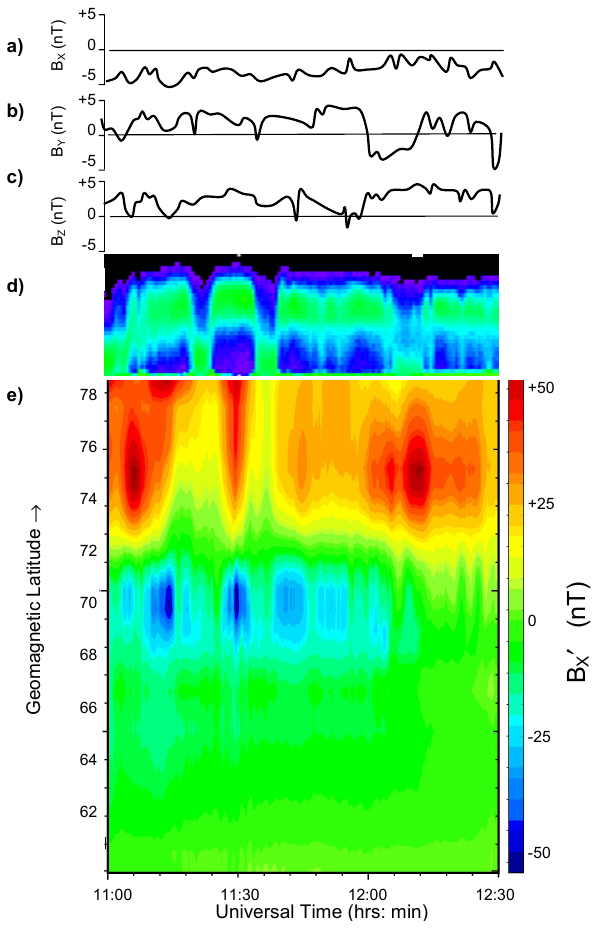
Fig. 7. (a)–(c) represent the lagged (by 75min) variations of the IMF components B X , B Y and B Z in the GSM reference frame; (d) the energy-time spectrogram of the electron data seen by PEACE- C4 (as shown in Figs. 1 and 3), and (e) the “upward continuation” of the X component of the magnetic field B X 0 as a function of latitude and from the IMAGE magnetometer chain. The technique used to derive B X 0 employs Fourier analysis of the observations of the data from the latitudinal chain of stations on the ground to reconstruct high-resolution latitude variations that would have been observed just below the current